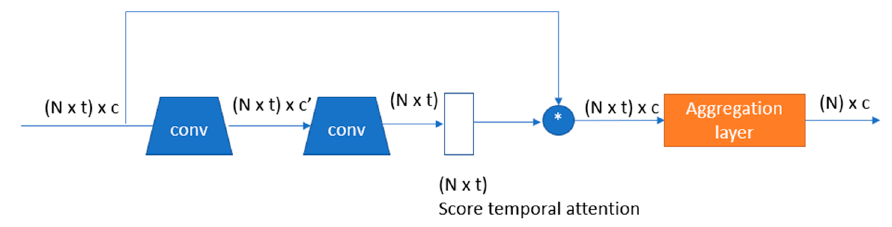
Figure 5. Temporal